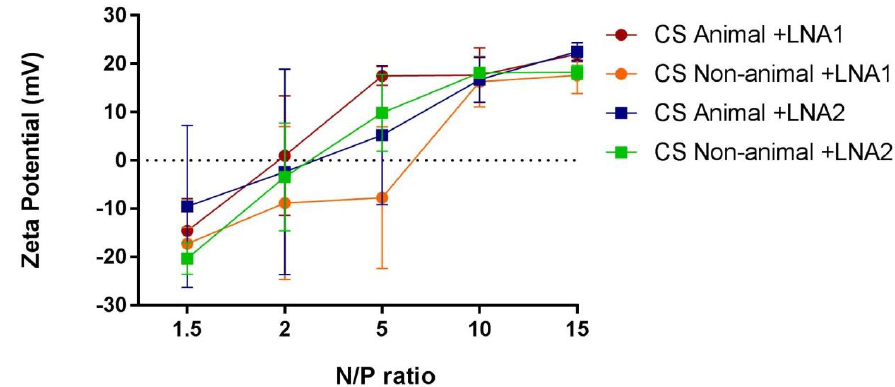
Figure 5. Variation of the zeta potential (mV) of chitosan (animal and non-animal) NPs formed with LNA1 and LNA2 at varying N/P ratios (1.5, 2, 5, 10, 15). The values represented are the mean ± SD of three independent experiments